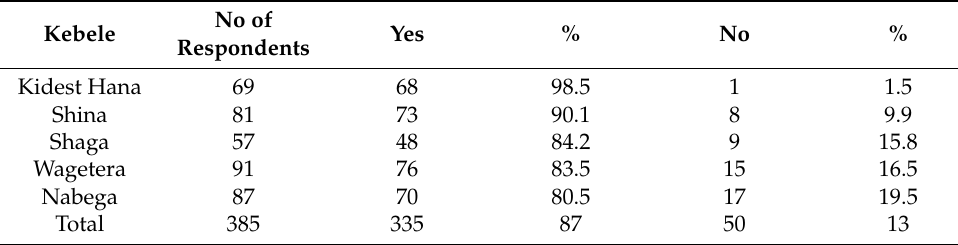
Table 2. Farmers’ participation in the rice market in Fogera Woreda.